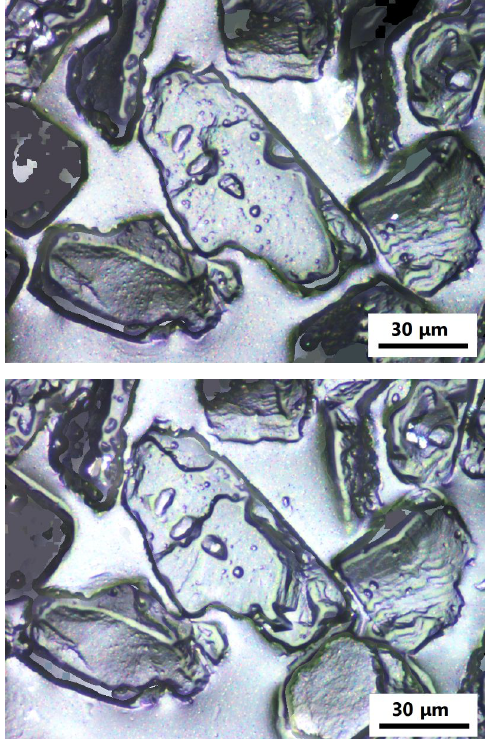
Figure 1. Grains on a new grinding wheel ( top ) and after grinding using that wheel ( bottom ): visible wear due to breaking grains from the binder (views of 3D texture